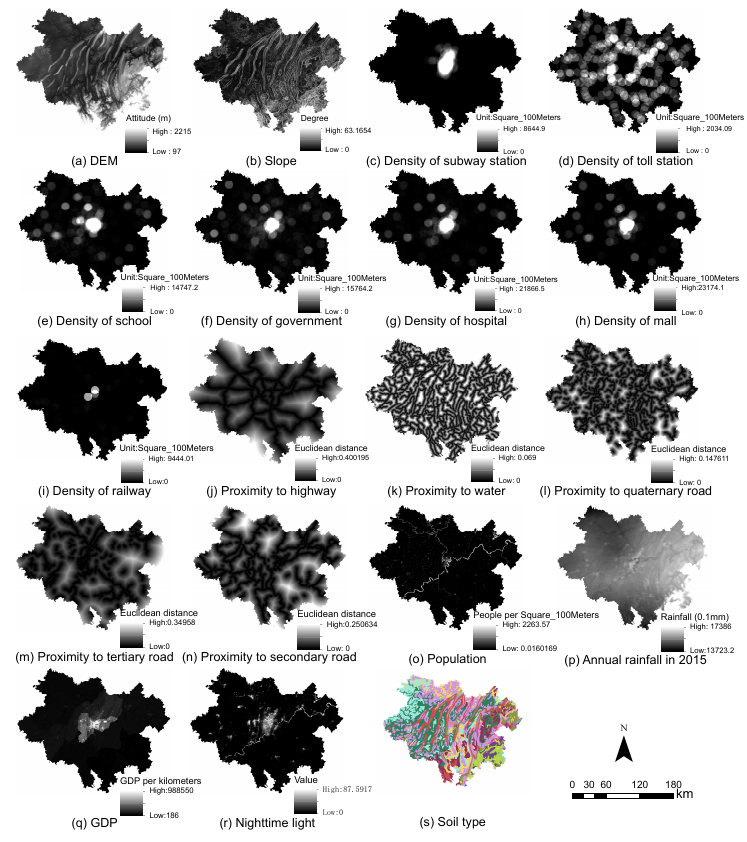
Figure 2. Driving factors of